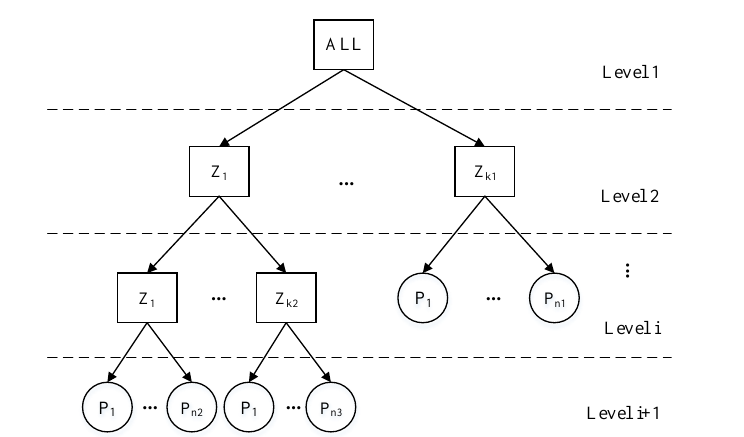
Figure 2. Regional division based on IFCM.